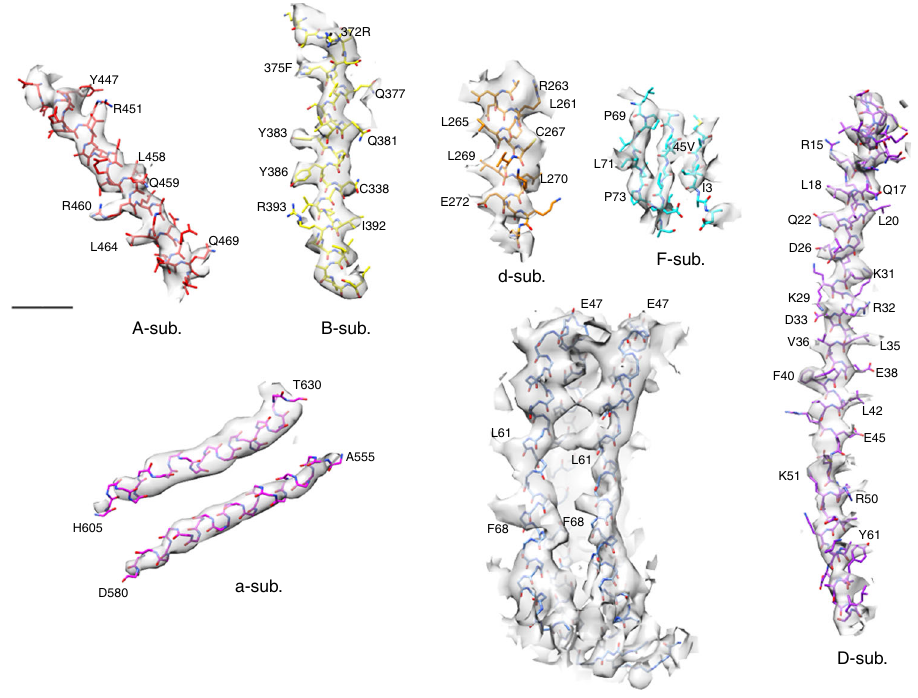
Fig. 6 Examples of the fi t of the model and density maps of state1. Amino acids for which side chain density was observed are indicated. Experimental maps are shown in semi-transparent gray. Scale bar, 10